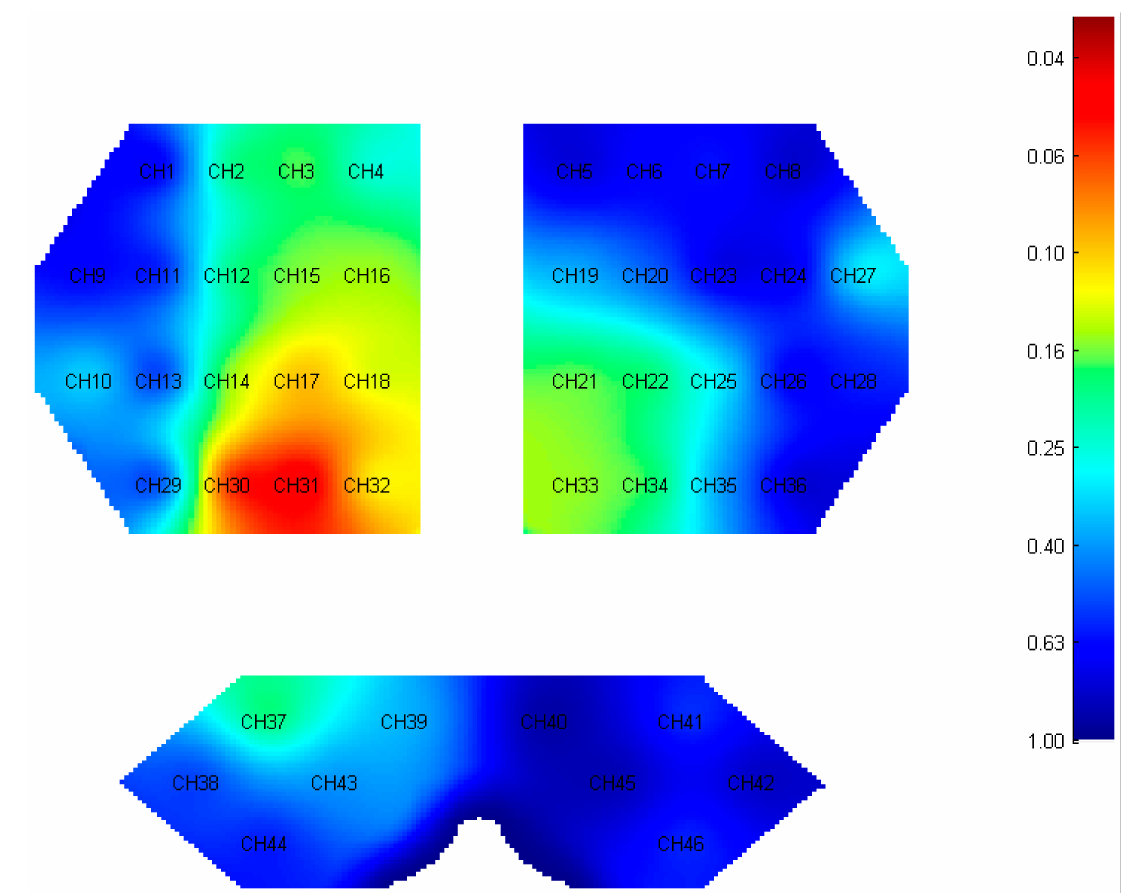
Figure 4. Activation of all channels. The value is represented by adjusted p for β . The smaller value is closer to red, otherwise, the color is closer to